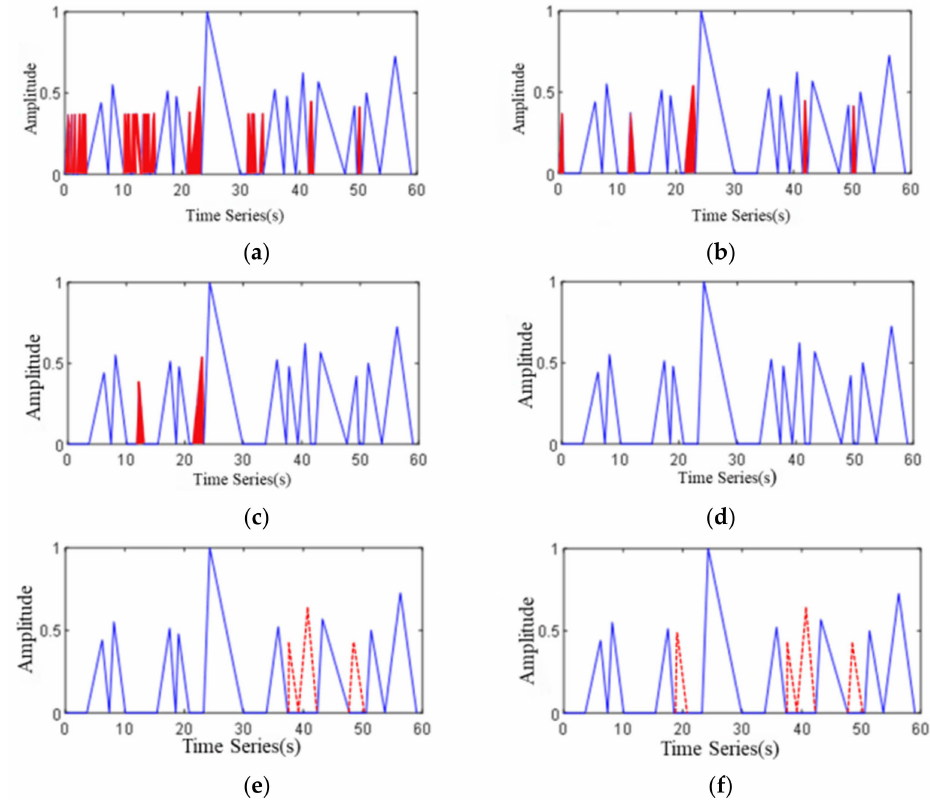
Figure 11. Comparison of the minimum frame length of different vehicle signal segments. ( a ) 10-frame, ( b ) 20-frame, ( c ) 30-frame, ( d ) 40-frame, ( e ) 50-frame and ( f )